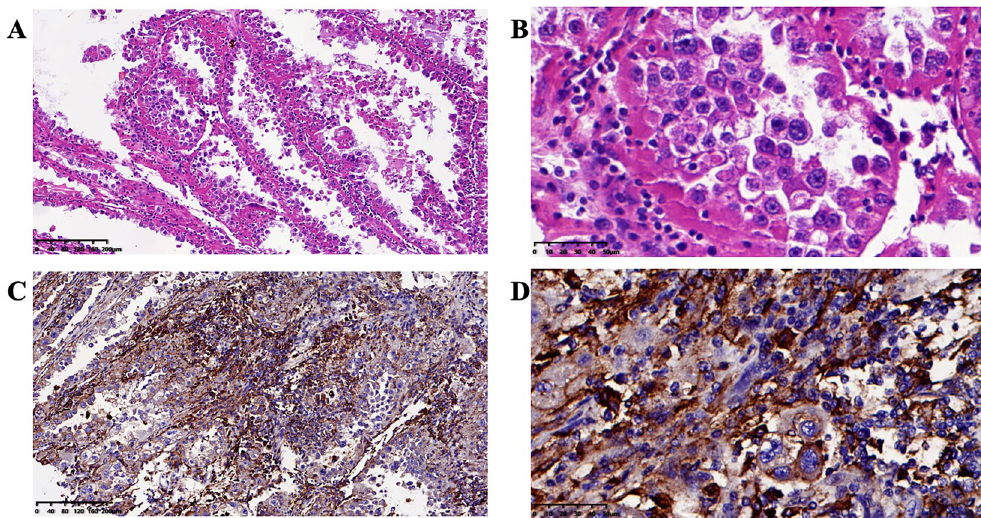
Figure 2. Photomicrography: microscopic results of abdominal wall clear cell cancer. (A) Hematoxylin and eosin stain with magnification ×100. ( B ) Hematoxylin and eosin stain with magnification ×400. ( C ) PD-L1 immuno-histochemical stain with magnification ×100. ( D ) PD-L1 immuno-histochemical stain with magnification